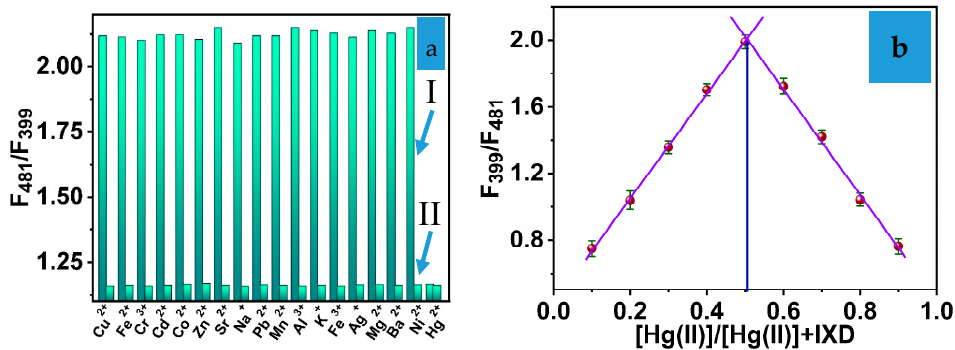
Figure 7. ( a ) IXZD emission spectra at 481 nm under 351 nm excitation (I) in the presence of inter ‐ fering cations and (II) interfering cations and Hg(II). The IXZD: Hg(II) is 1:1; ( b ) Job’s plot for deter ‐ mination of the IXZD: Hg(II) stoichiometry.